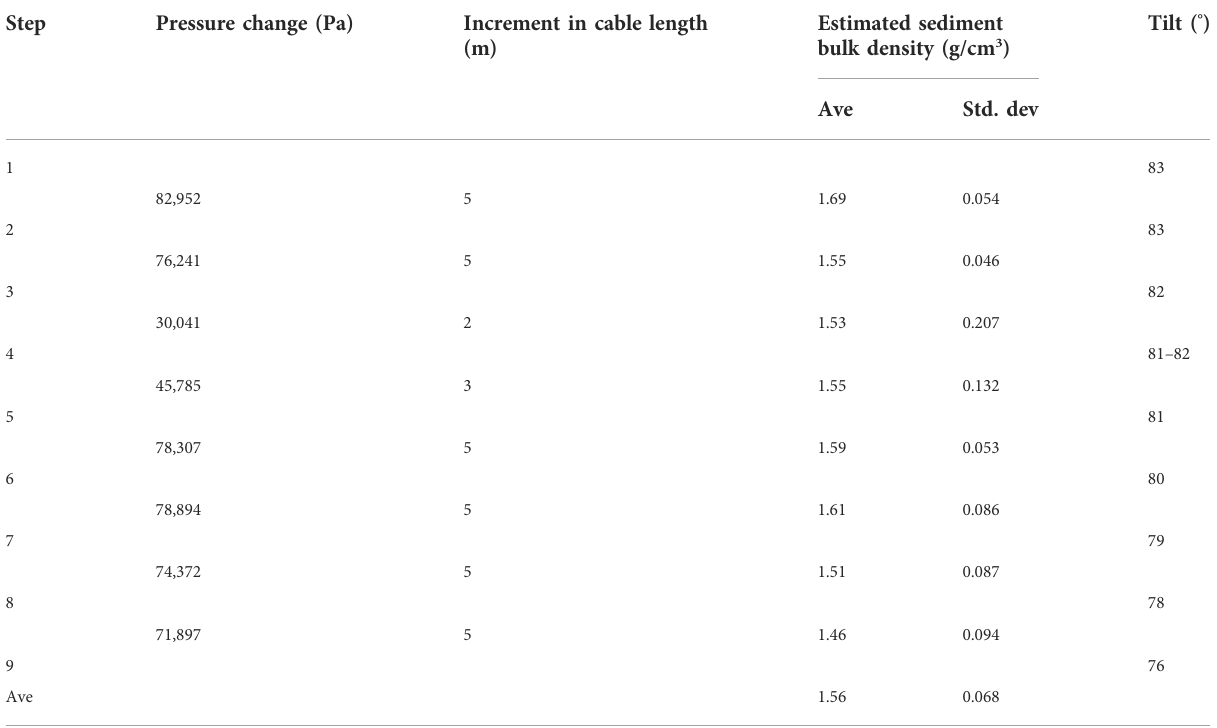
TABLE 2 Summary of sediment bulk density estimation during Observation C2 (Site